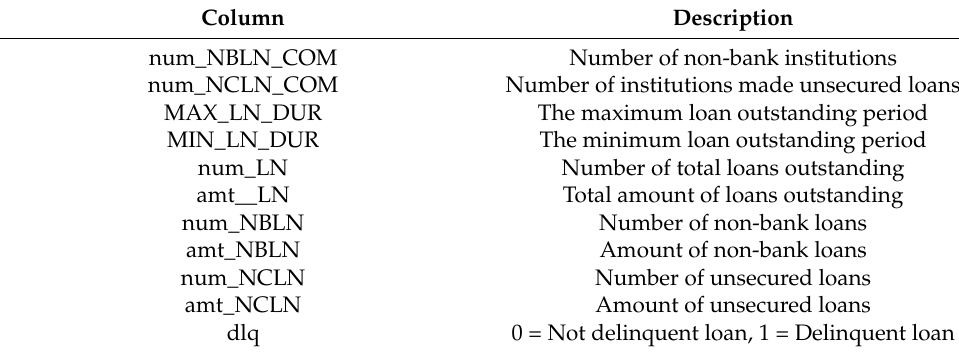
Table 3. Predictor variables to forecast delinquency.